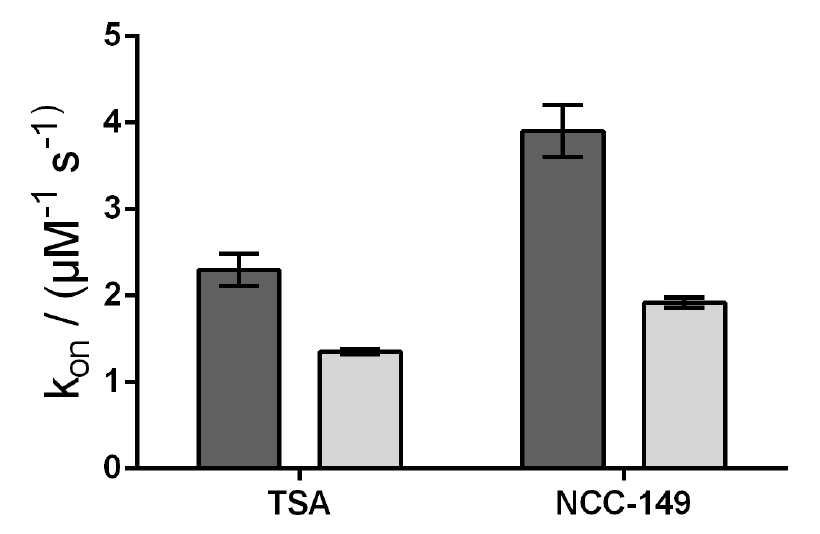
Figure 6. Comparison of the rate constants of association for TSA and NCC-149 between HDAC8 wt (dark gray bars) and HDAC8 M274A (light gray bars). Rate constants were determined by stopped- flow kinetics.